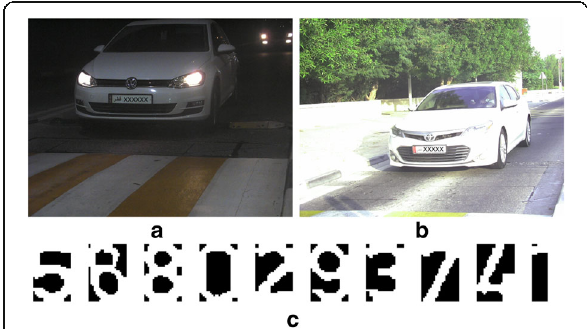
Fig. 5 Examples of the images and characters used to test